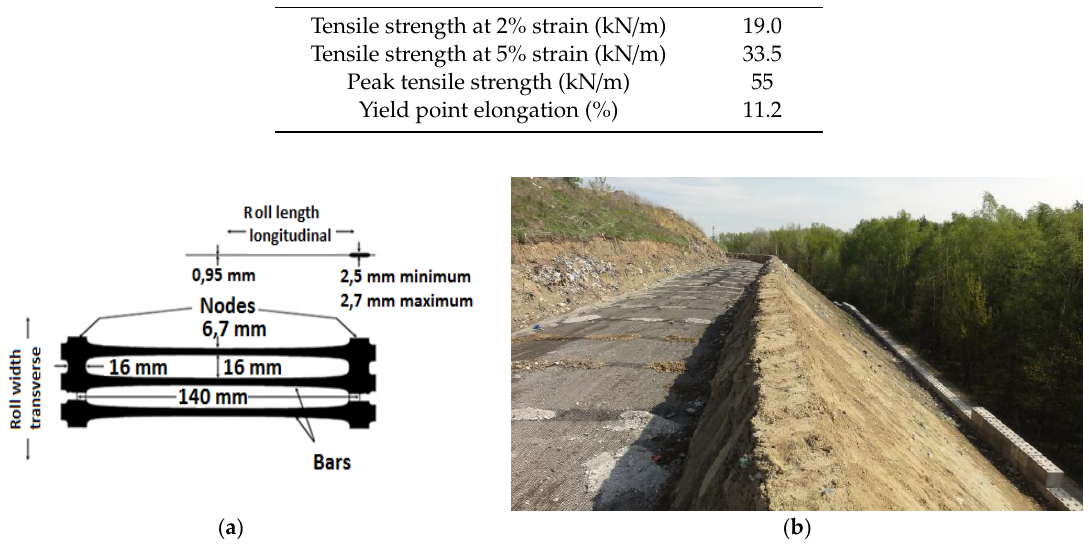
Figure 2. ( a ) Geometry of uniaxial geogrid and ( b ) landfill slope reinforced with geogrid;